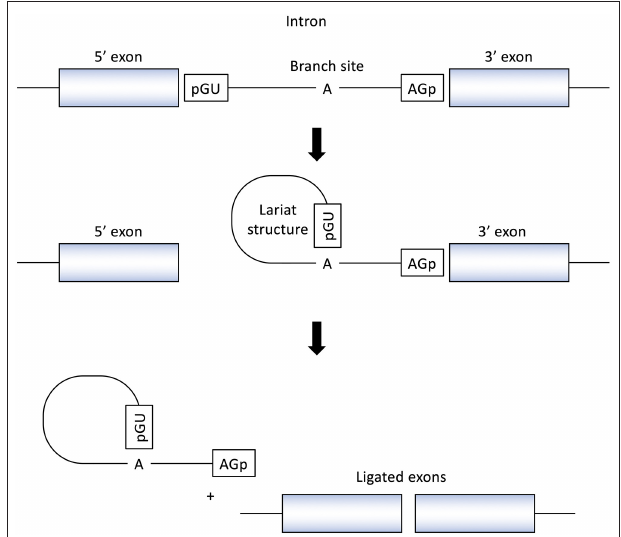
FIGURE 1 | Splicing reactions and important splicing elements. There are several essential splicing motifs located in boundary region between exons and introns. In addition to highly conserved dinucleotides of both 5 ′ and 3 ′ side of intron (GU/AG), adenosine (A) at the branch site and polypyrimidine tract (not shown in figure) are located in intron. pre-mRNA splicing process take place in two transesterification steps. In the first step, the 2 ′ -OH group of the adenosine (A) at the branch site performs a nucleophilic attack on a phosphate (p) at the 5 ′ splice site. This leads to cleavage of the 5 ′ exon from the intron and the formation of a lariat structure. In the following step, a second transesterification reaction, which involves the phosphate at the 3 ′ end of the intron, detach the intron from exon and ligates the two